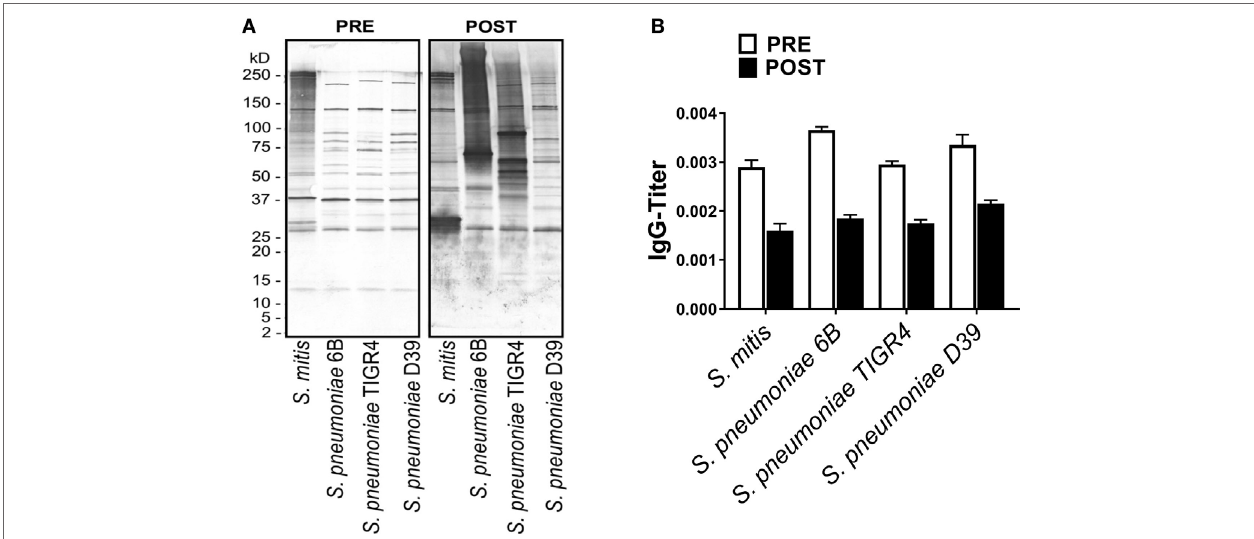
FigUre 4 | Reactivity of rabbit antiserum raised against Streptococcus pneumoniae with Streptococcus mitis . (a) Reactivity of a rabbit antiserum raised against a pool of S. pneumoniae serotypes (1, 2, 4, 5, 11, 18, 20, 22, and 33), with S. mitis and S. pneumoniae strains (6B, TIGR4, and D39) using SDS-PAGE and immunoblotting. Each lane was loaded with 50 µg of protein from each bacterial species. The pre- and post-inoculation sera were diluted 1:1,000. (B) Pre- and post-immunization levels of S. mitis -reactive IgG antibodies from a S. pneumoniae -immunized rabbit. The titer of IgG antibodies was determined by converting the OD values to titers, with a cutoff of OD value of 0.40 (see legend to Figure 2 ). The bars show averages of two replicates. Abbreviations: PRE, pre-inoculation sera; POST, post-inoculation